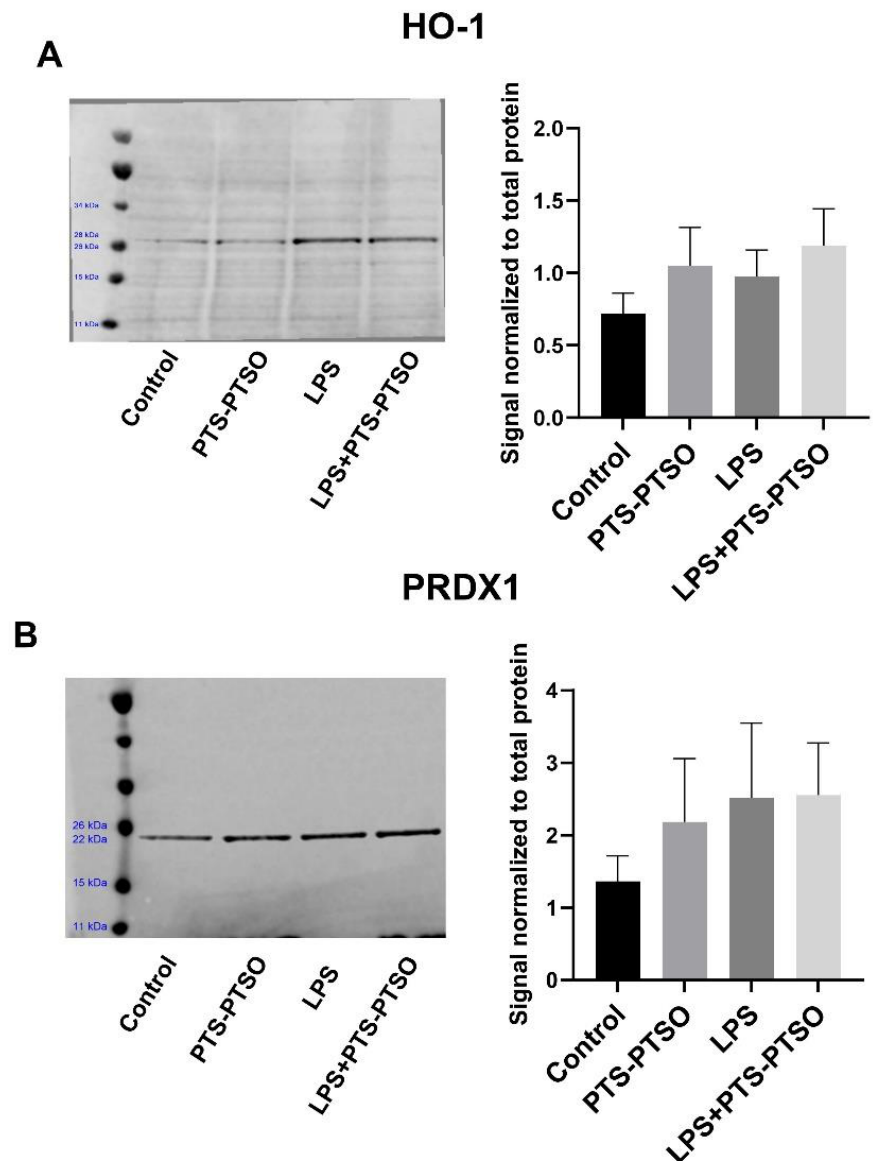
Figure 3. PTS-PTSO does not affect antioxidant protein expression of HO-1 and PRDX1 in murine macrophages. Western blot was conducted to assess HO-1 and PRDX1 protein expression. ( A ) Signal normalized to total protein of HO-1 in RAW264.7 cells stimulated with PTS-PTSO and LPS. n = 6 replicates per treatment group ( B ) Signal normalized to total protein of PRDX1 in RAW264.7 cells stimulated with PTS-PTSO and LPS, n = 8 replicates per treatment.